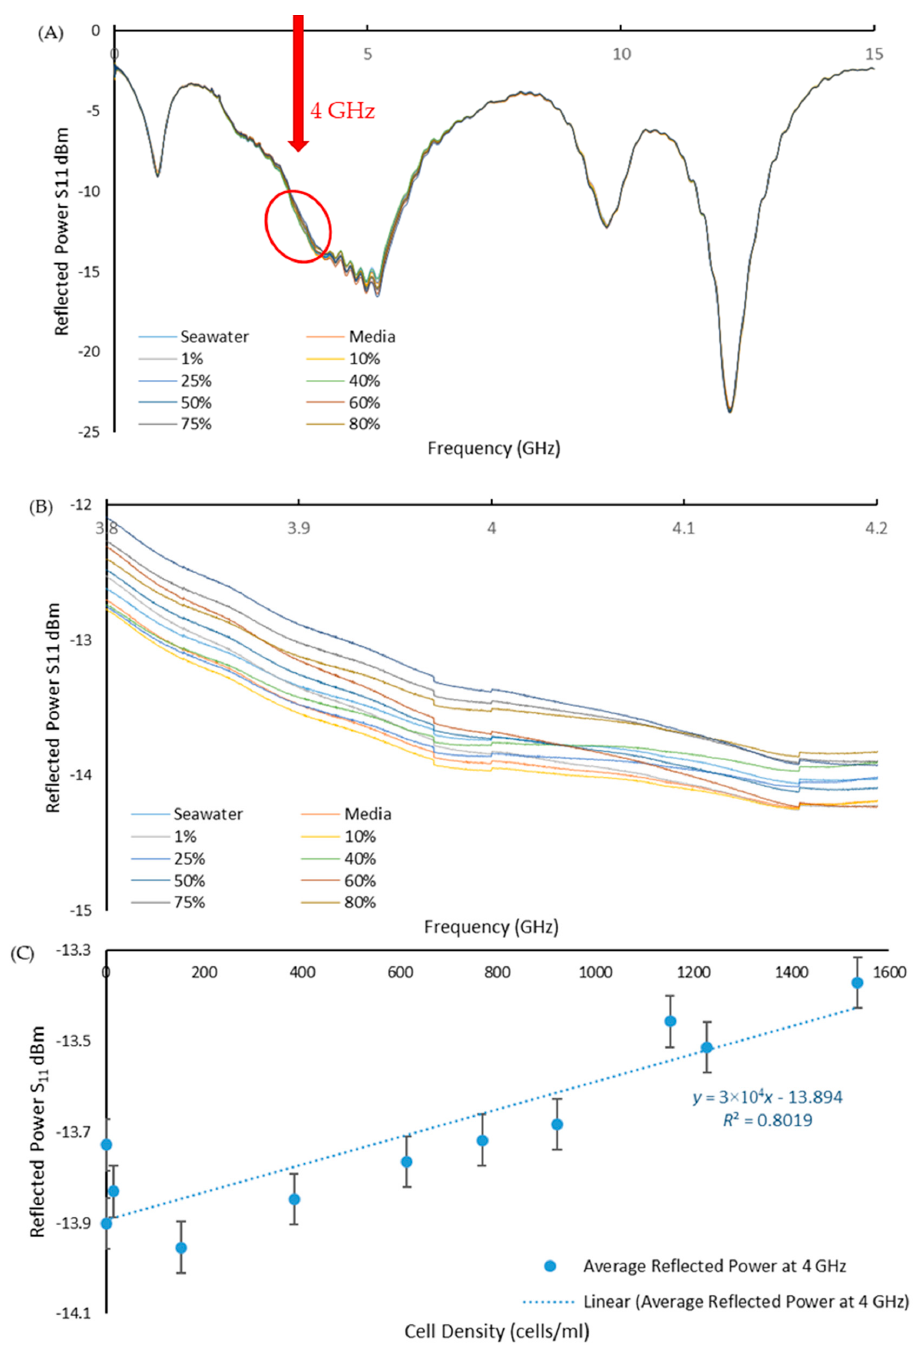
Figure 5. ( A ) Reflected power S 11 versus frequency graph for PTFE 8pr Au in 0.01–15 GHz frequency range; ( B ) magnified part of spectra ( A ) (in red circle) in 3.8–4.2 GHz range to illustrate the effect of the cells concentration change on the amplitude of the reflected power signal; and ( C ) Linear change ( R 2 = 0.8019) in the reflected power S 11 amplitude with increasing cell density at 4 GHz